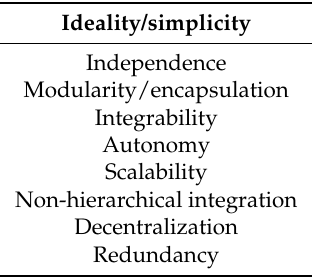
Table 1. Fricke and Schultz’s design principles for changeability